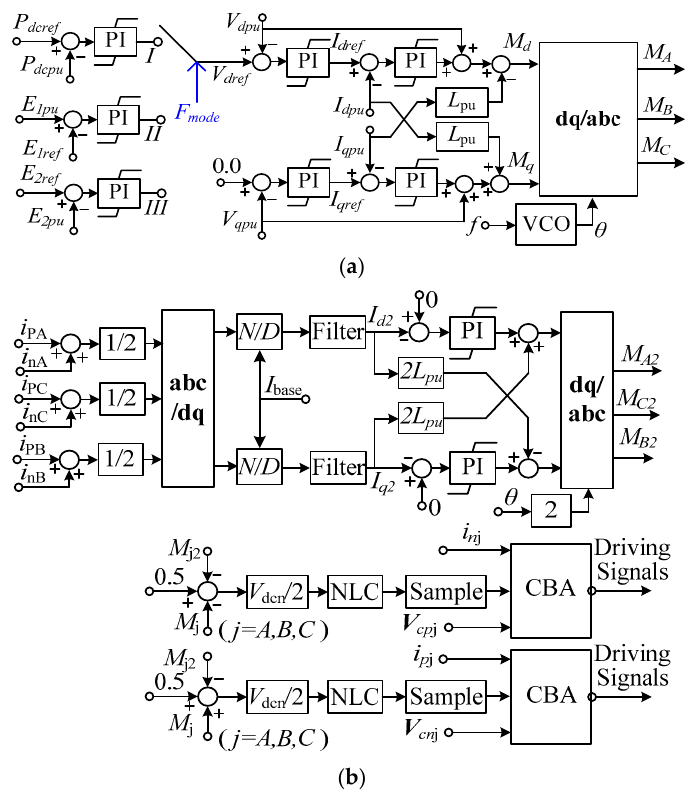
Figure 2. Control diagrams of UUDAT and DUDAT. ( a ) Upper level control of a UUDAT or DUDAT; ( b ) Lower level control of UUDAT and DUDAT.